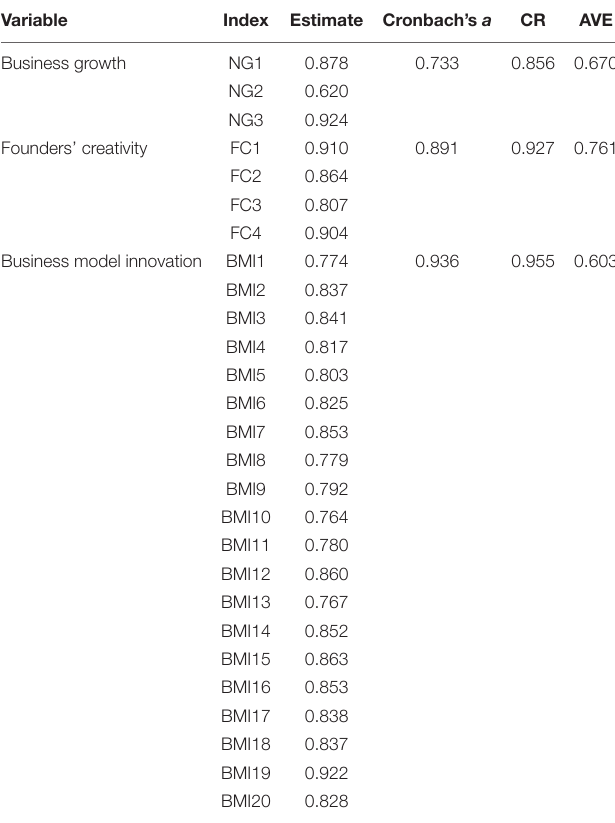
TABLE 2 | Reliability and validity test